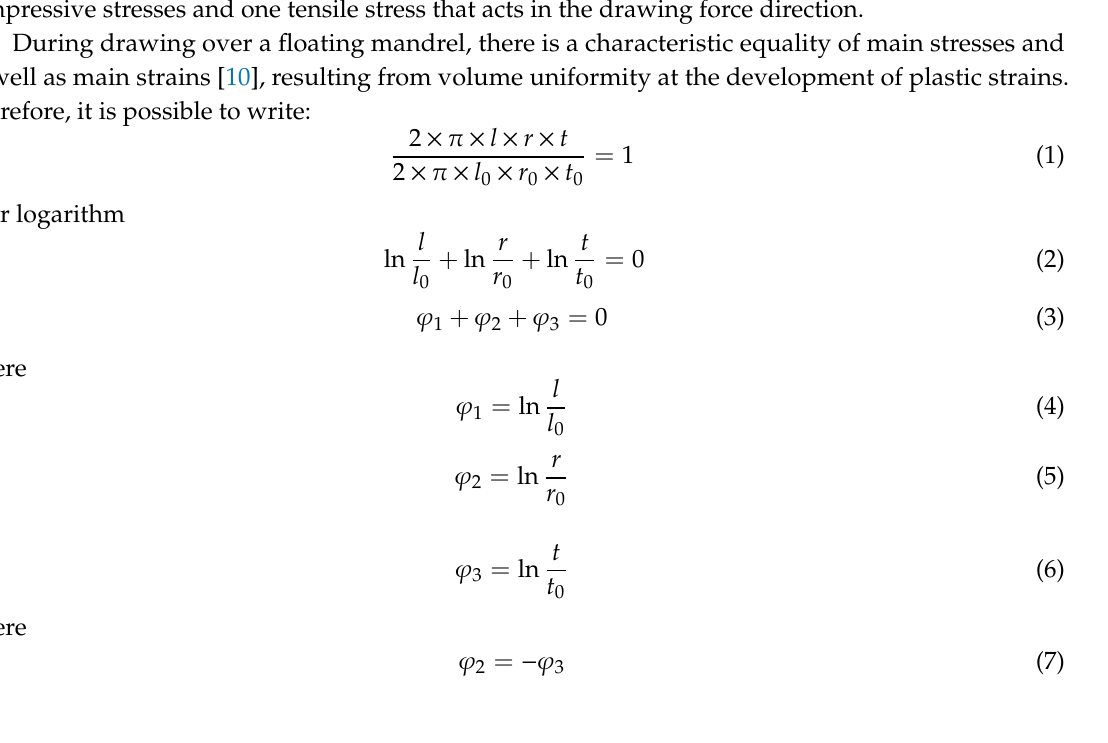
Figure 5. The tube EW longitudinal section.